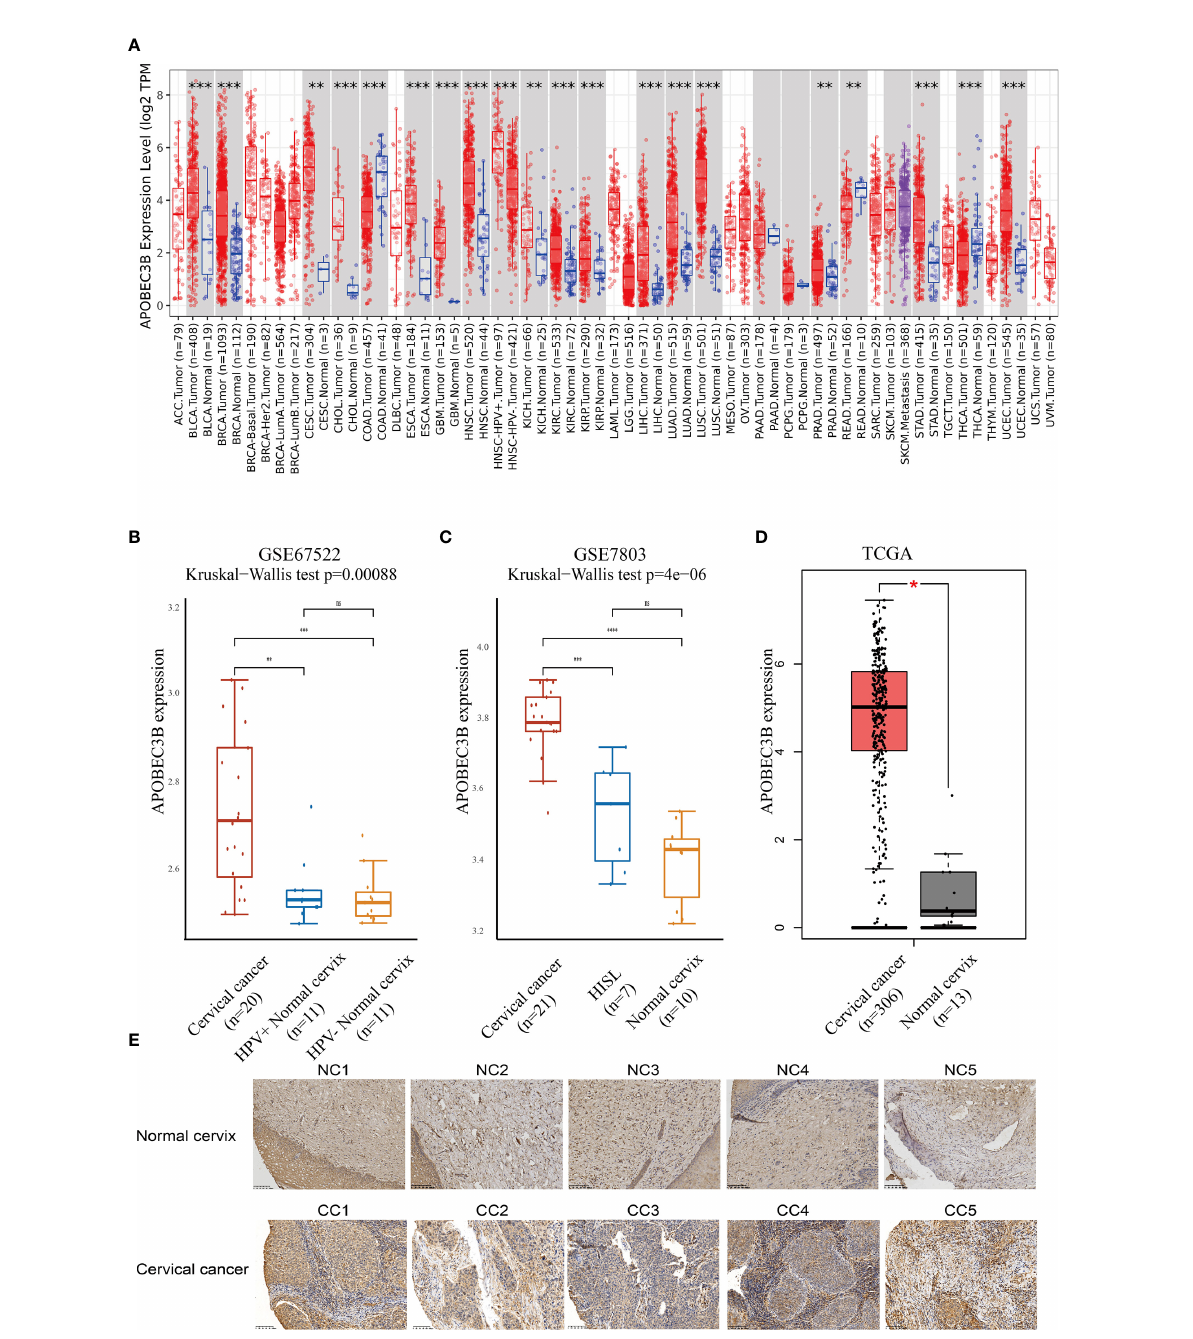
FIGURE 1 APOBEC3B was highly expressed in tumor tissues. (A) Expression levels of A3B in different TCGA cancer types. A3B levels were signi fi cantly higher than normal tissue in various cancers in TCGA database. (B) Cervical cancer expressed A3B at a higher level compared with HPV+ and HPV − normal cervix in GSE67522. (C) Cervical cancer had higher A3B expression compared to HISL and normal cervix in GSE7803. (D) A3B showed a higher expression of cervical cancer than the normal cervix. Data are presented as the mean ± SD, and results were analyzed by a two-sided Student ’ s t -test. (E) High A3B expression in cervical cancer tissue. * p < 0.05; ** p < 0.01; *** p < 0.001. **** p < 0.0001; ns, no signi fi